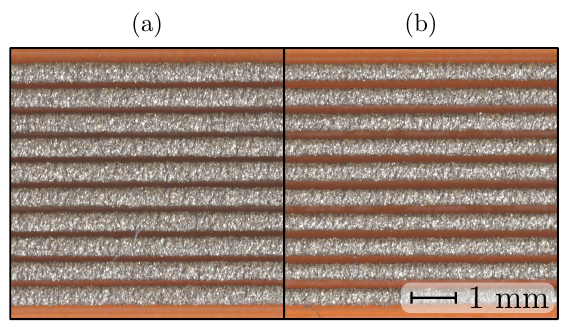
Figure 3. Printing speed v influence: ( a ) v = 10mm/s, ( b ) v = 40mm/s.